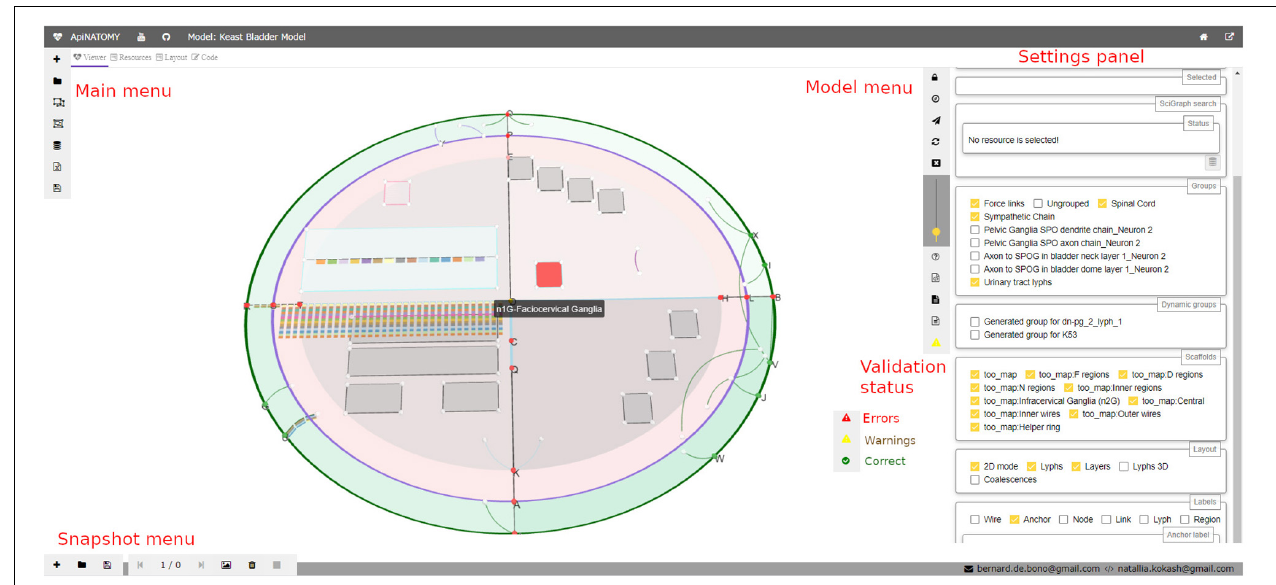
FIGURE 3 | A snapshot of the ApiNATOMY viewer web application. In the main view, a user can see an ApiNATOMY model of the Spinal Cord, Sympathetic Chain, and Urinary Tract, placed in the context of the TOO Map. On the left hand side, there is the main menu for loading and composing models. On the right hand side, there is the model menu that provides controls for the interaction with the currently displayed model, and the settings panel that provides access to relevant model and visualization parameters. At the bottom of the model menu users can see model status: the demo model has warnings. At the bottom of the viewer, there is the snapshot menu to create visualization snapshots and switch between recorded model